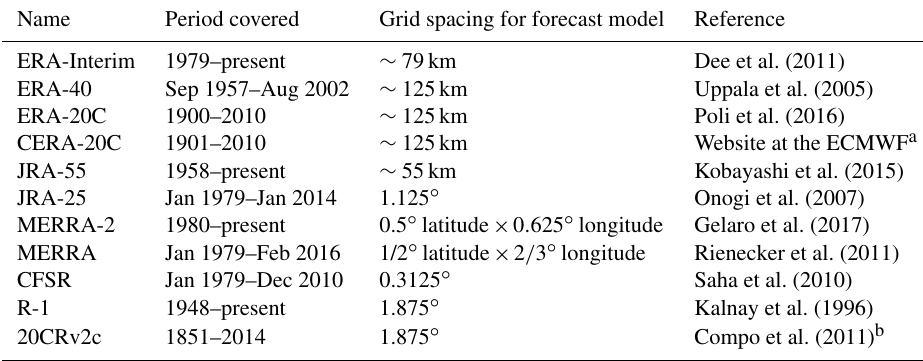
Table 1. List of global atmospheric reanalysis data sets analysed in this study.